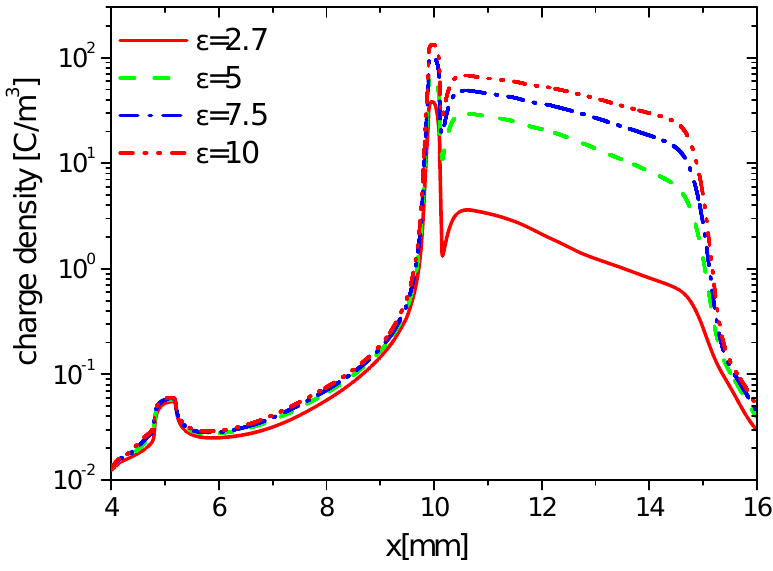
Figure 11. Effect of ε on the distributions of the wall charge density at 15 ns in the rise